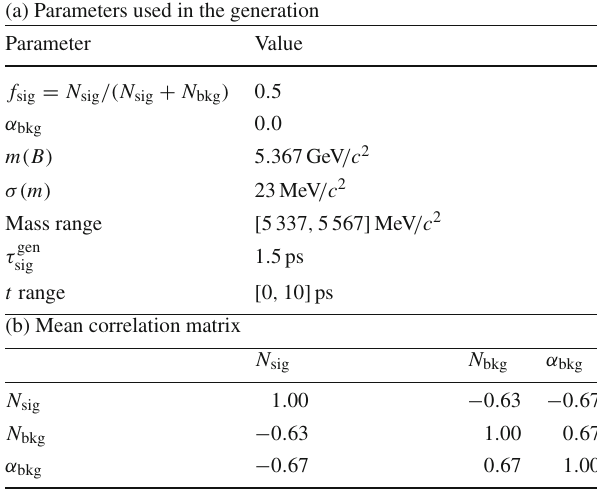
Table 1 (Left) The parameters used in the generation of the pseudoex- periments. Only N sig , N bkg , and the background slope α bkg are varied in the mass fit. The background slope α bkg is then fixed for the deter- mination of the sWeights . (Right) the mean correlation matrix from the mass fit when both the yields and α bkg are allowed to